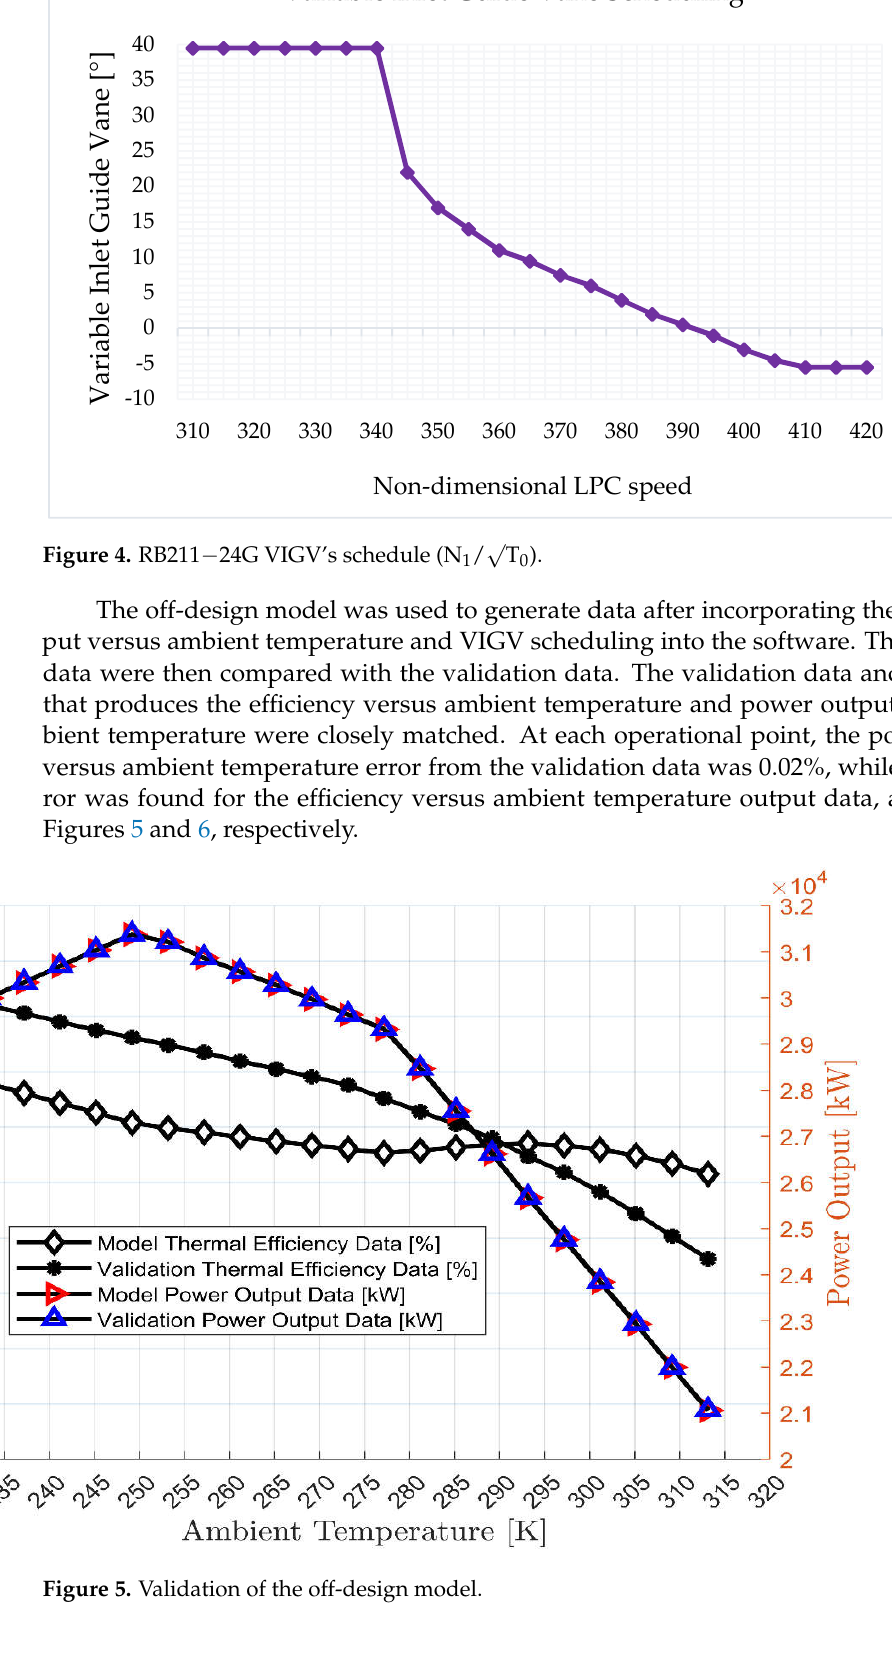
Figure 5. Validation of the off-design model.